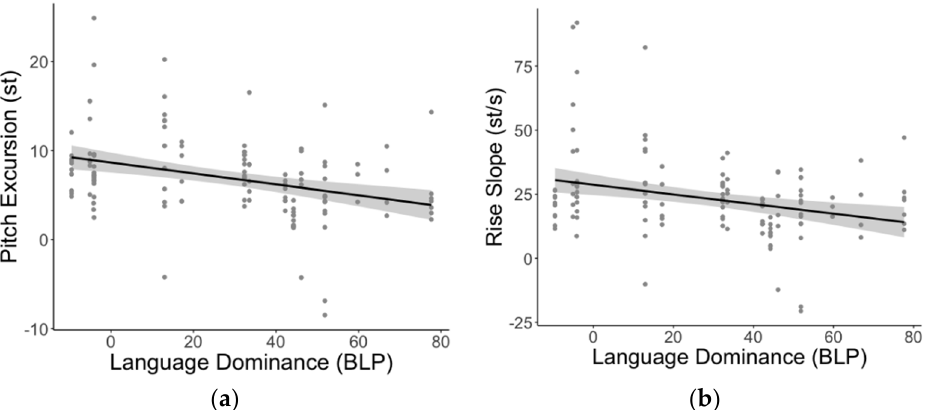
Figure 4. ( a ) Pitch excursion (st) of uptalks by language dominance (BLP); ( b ) Rise slope of uptalks (st/s) by language dominance (BLP).